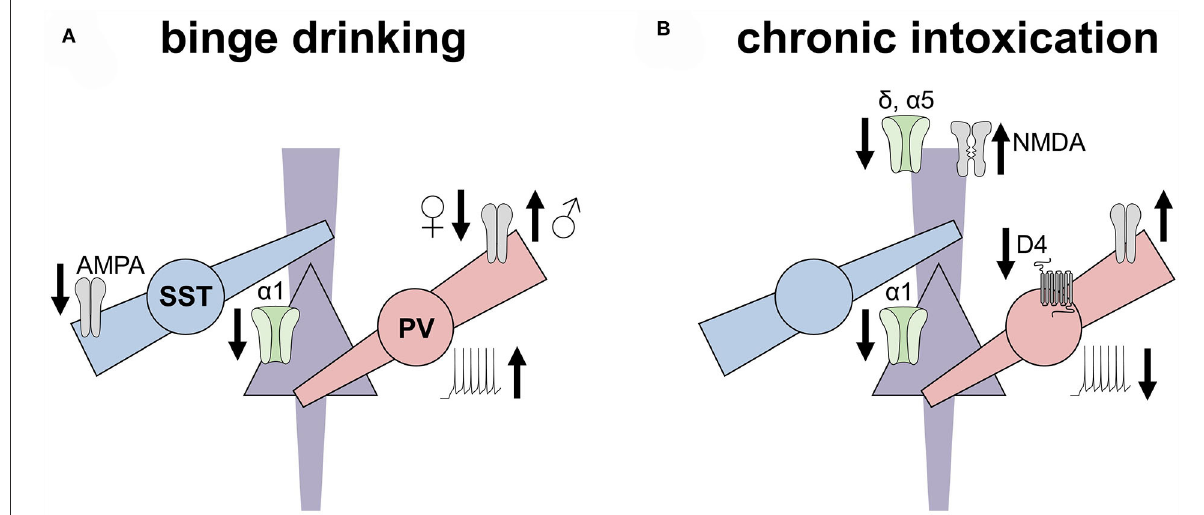
FIGURE2 Ethanol experiences induced disparate adaptations to inhibitory microcircuits in the rodent prefrontal cortex. This non-exhaustive figure highlights key adaptations to the prefrontal cortex inhibitory microcircuits observed in rodent models of binge drinking (left) and dependence (right). (A) Excitatory drive onto somatostatin interneurons (SST-INs) is decreased following chronic voluntary drinking, along with a concomitant decrease in the expression of α 1 GABA A subunits on pyramidal cells. In contrast, excitatory drive onto parvalbumin (PV) INs is decreased in female mice but increased in male mice following binge drinking. PV-INs from drinking mice also exhibit enhanced excitability. (B) After chronic intoxication or dependence, however, PV-INs display reduced excitability relative to controls, along with reduced regulation by dopamine receptors. Increased excitatory drive onto PV-INs of both female and male mice has also been observed following the induction of ethanol place preference but not place aversion. Pyramidal cells from dependent animals display reduced α 1 and α 5 GABA receptor subunits, the latter of which may relate to increased NMDA receptor function observed in these